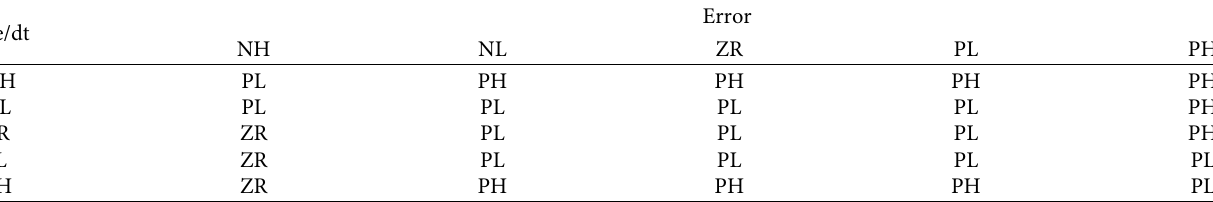
Table 1: If-then fuzzy logic rule base for ∆ k